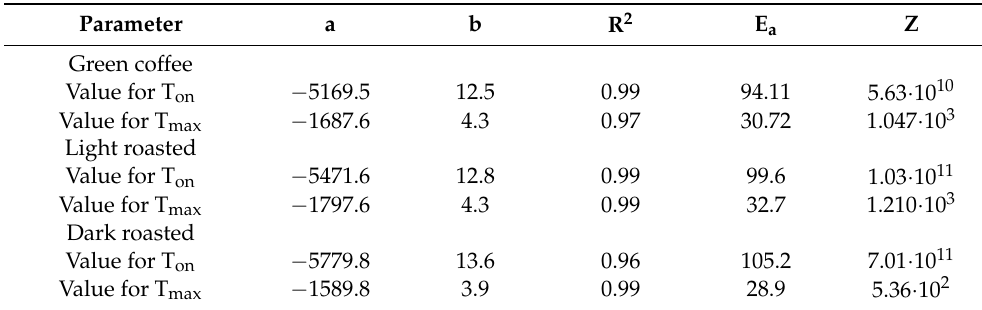
Table 4. Statistical and kinetic parameters characterizing the thermal-oxidative decomposition of